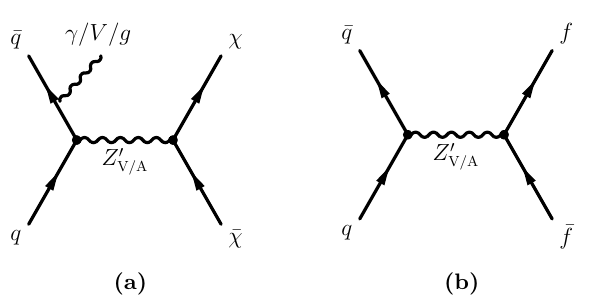
Figure 1. Schematic representation of the dominant production and decay modes for the V/AV model.